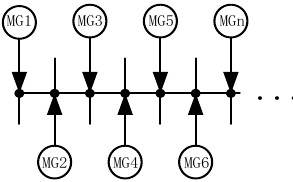
Figure 1. Multi-microgrid system topology.